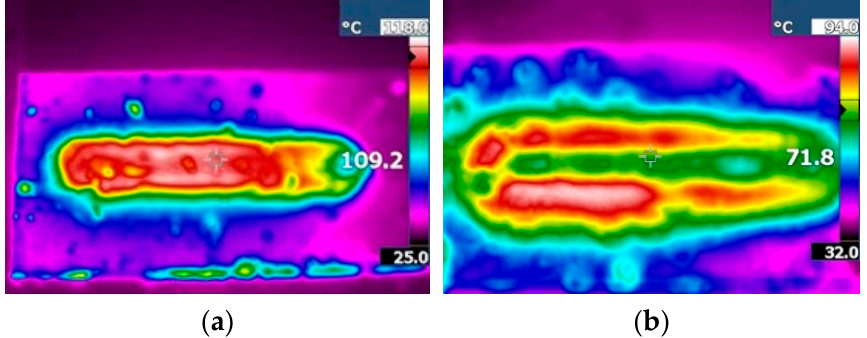
Figure 2. Thermal imaging of single-pass single-layer surfacing on the substrate. ( a ) 60 s after weld- ing. ( b ) 80 s after welding.